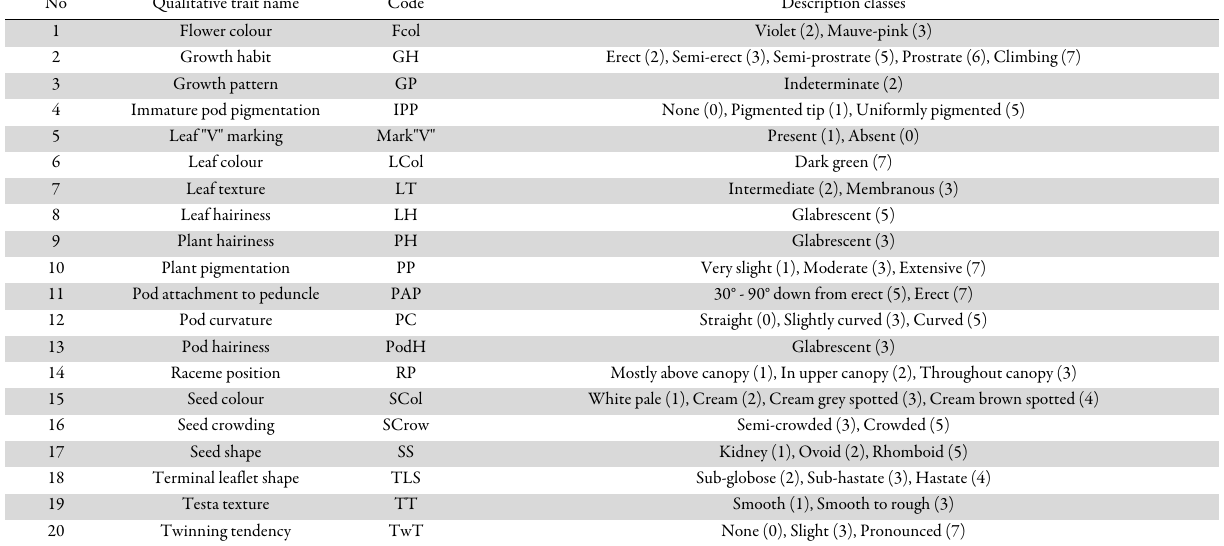
Table 1. List of qualitative traits used in this study and observed description